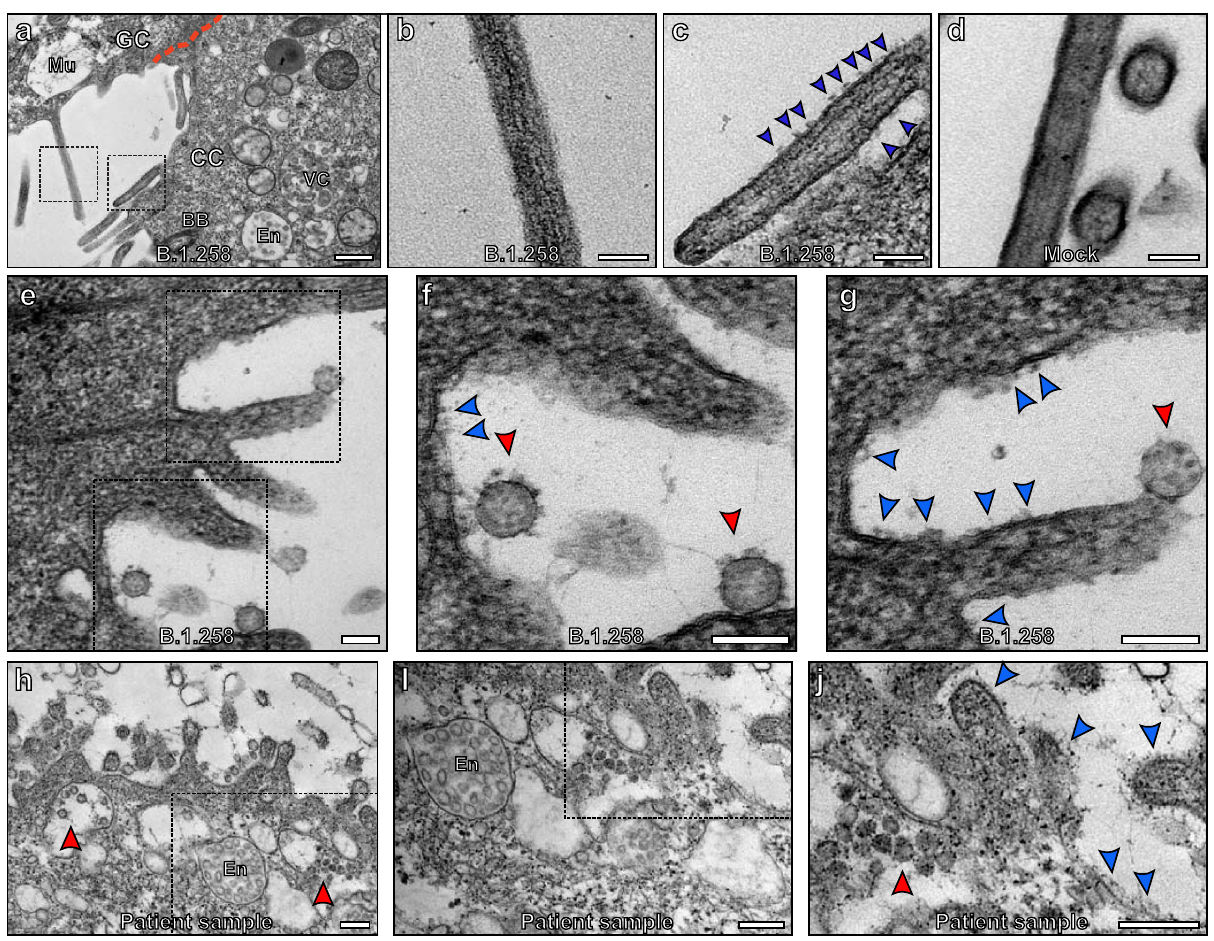
Fig. 5 S glycoprotein-like protrusions were found on microvilli and plasma membrane of infected cells. a An uninfected goblet cell (GC) next to an infected ciliated cell (CC) that has viral-containing compartments (VC) (endosome (En) and basal bodies (BB) were also visible). The goblet cell is identi fi able by the mucin-containing secretory granules (Mu) and the junction between the two cells false coloured with a red line. When looking at the microvilli from the goblet cell shown in ( a ) and at higher magni fi cation ( b ), the membrane is smooth. Conversely, the plasma membrane of the microvilli of the infected ciliated cell ( a ) and at higher magni fi cation ( c ), is not smooth and has protrusions (blue arrowheads). d The microvilli of a non-infected ciliated cell are smooth. e High magni fi cation images of the boxed regions ( f , g ) show infected cultured human airway epithelial cells where viral particles can be seen attached to the cell surface. The viral S glycoprotein (red arrowheads) has a similar pro fi le to the cell surface protrusions (blue arrowheads). h – j Cells acquired from a nasal brushing of an infected patient show the presence of viral particles (red arrowheads). I , j At higher magni fi cation protrusions are seen at the cell surface and on microvilli (blue arrowheads). Scale bars ( a ) 400 nm, ( b – g ) 100 nm, and ( h – j ) 200